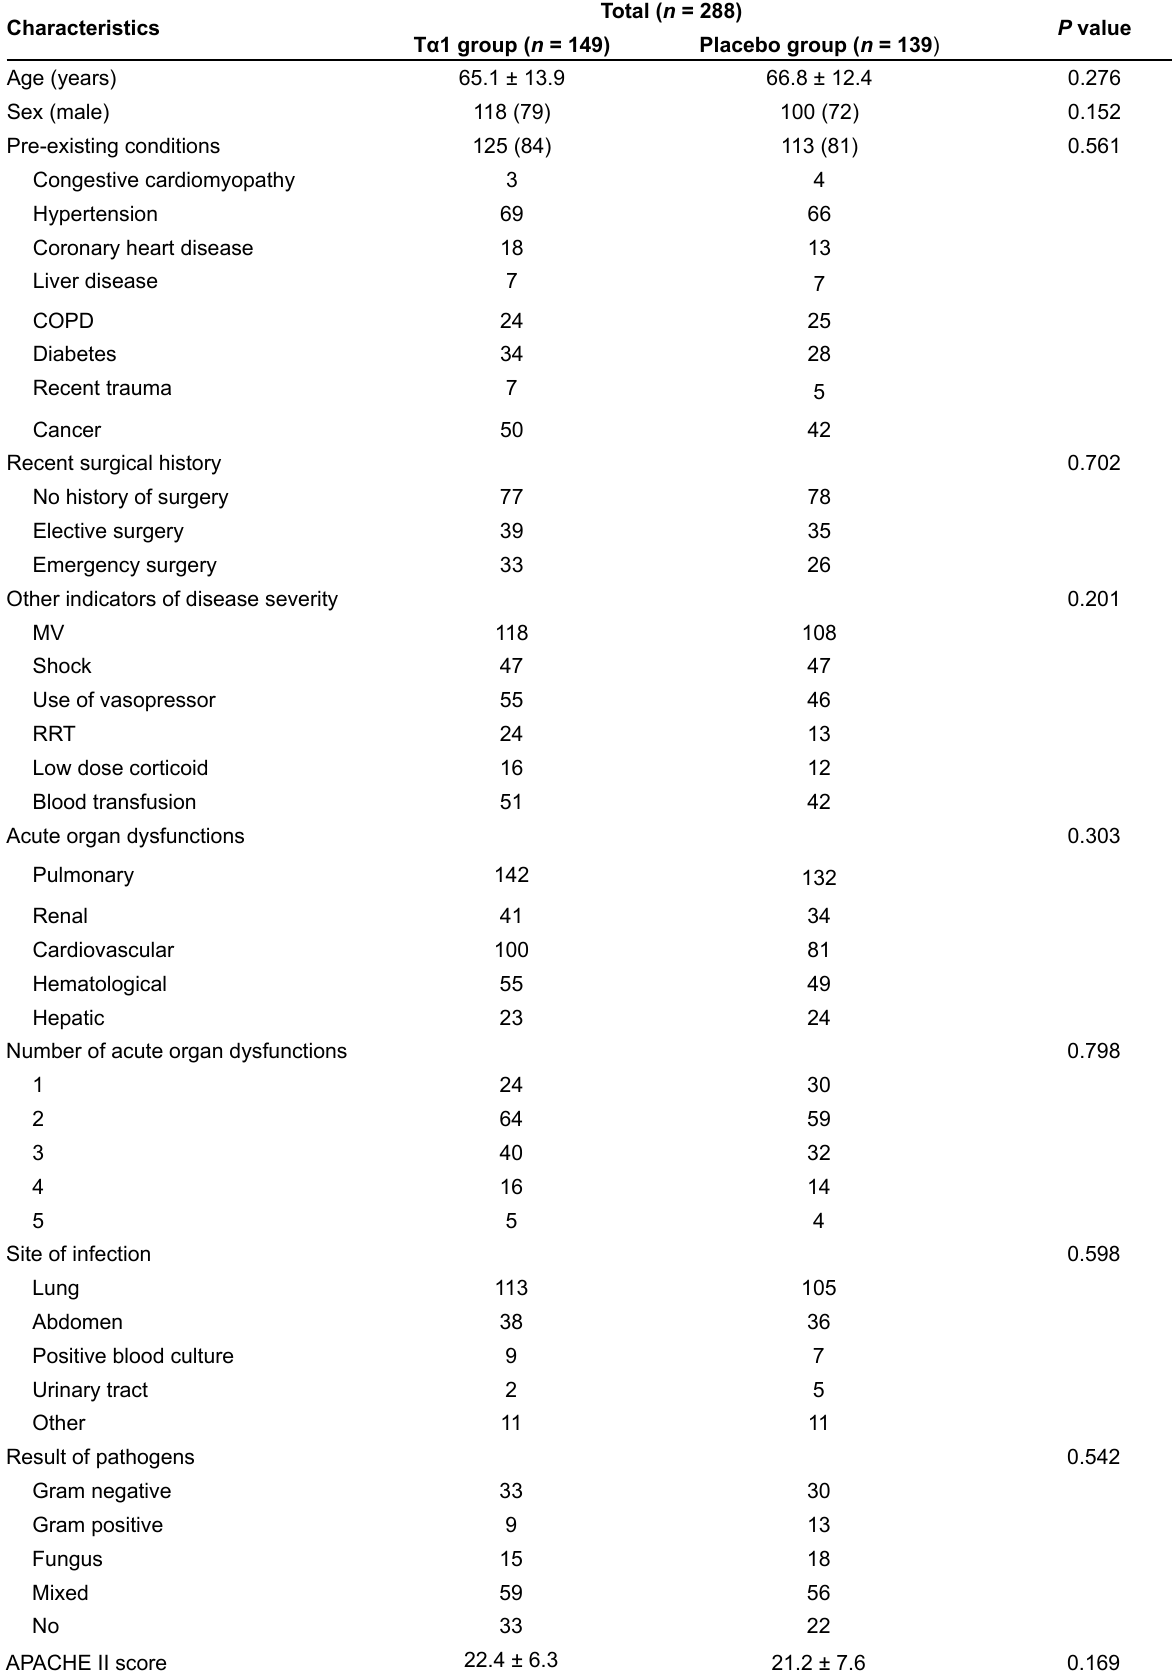
Table 1. Baseline clinical characteristics of patients with sepsis